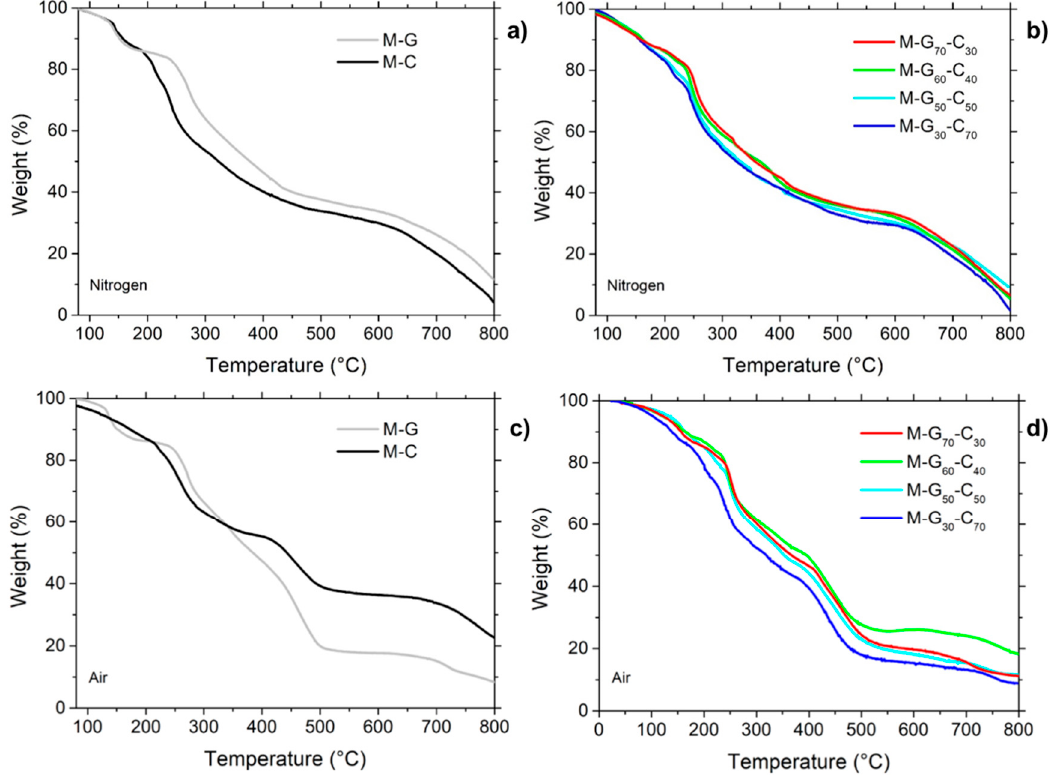
Figure 1. TG thermograms of PAA homopolymers and copolymers in nitrogen ( a , b ) and air ( c , d ). Add-ons: 16.0 ± 0.5%. Table 3. Thermal data of homopolymeric and copolymeric PAAs in nitrogen and air by thermogravimetric analysis.